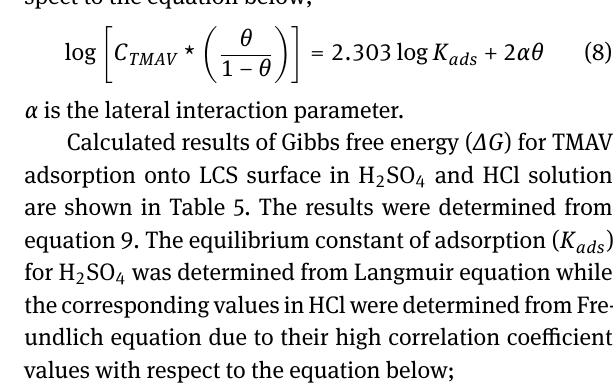
spect to the equation